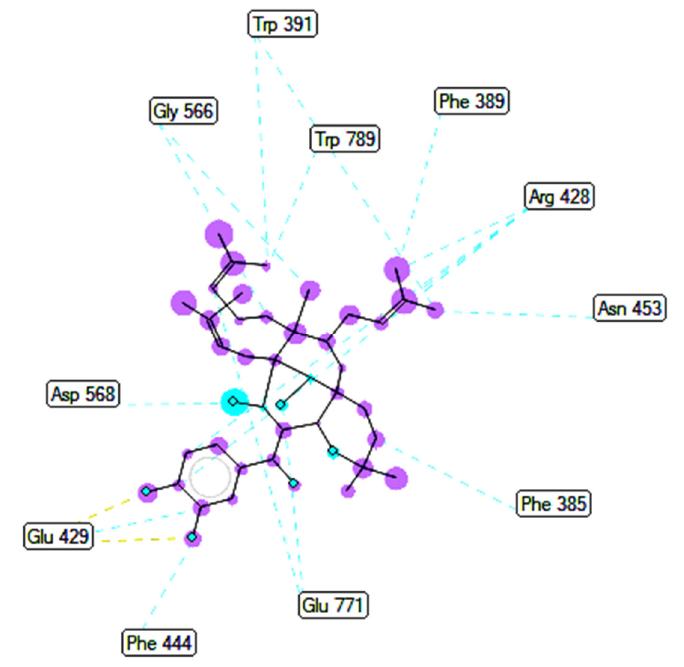
Figure 5. The ligand map shows the secondary interactions such as hydrogen bonds (yellow), steric interactions (light green), and overlap interactions (circle violet) between residual amino acids on enzyme 4J5T and pose 148, compound 1 .